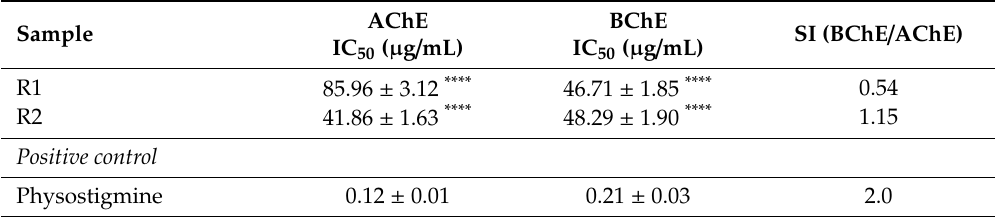
Table 2. Cholinesterases’ inhibitory activity of rosemary essential